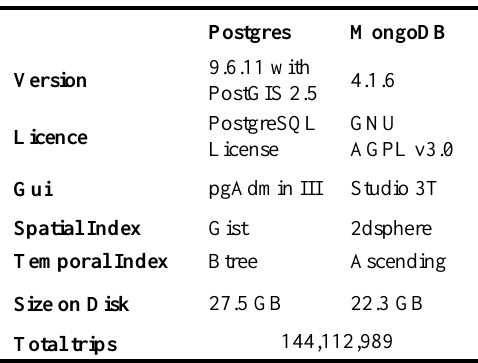
Table 1 Overview of the experimentation